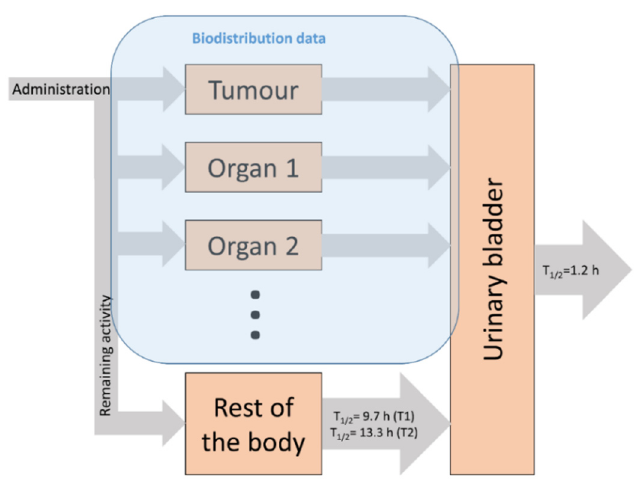
Figure A1. Biological pathway of the radiotracer. Biodistribution data are used to estimate the